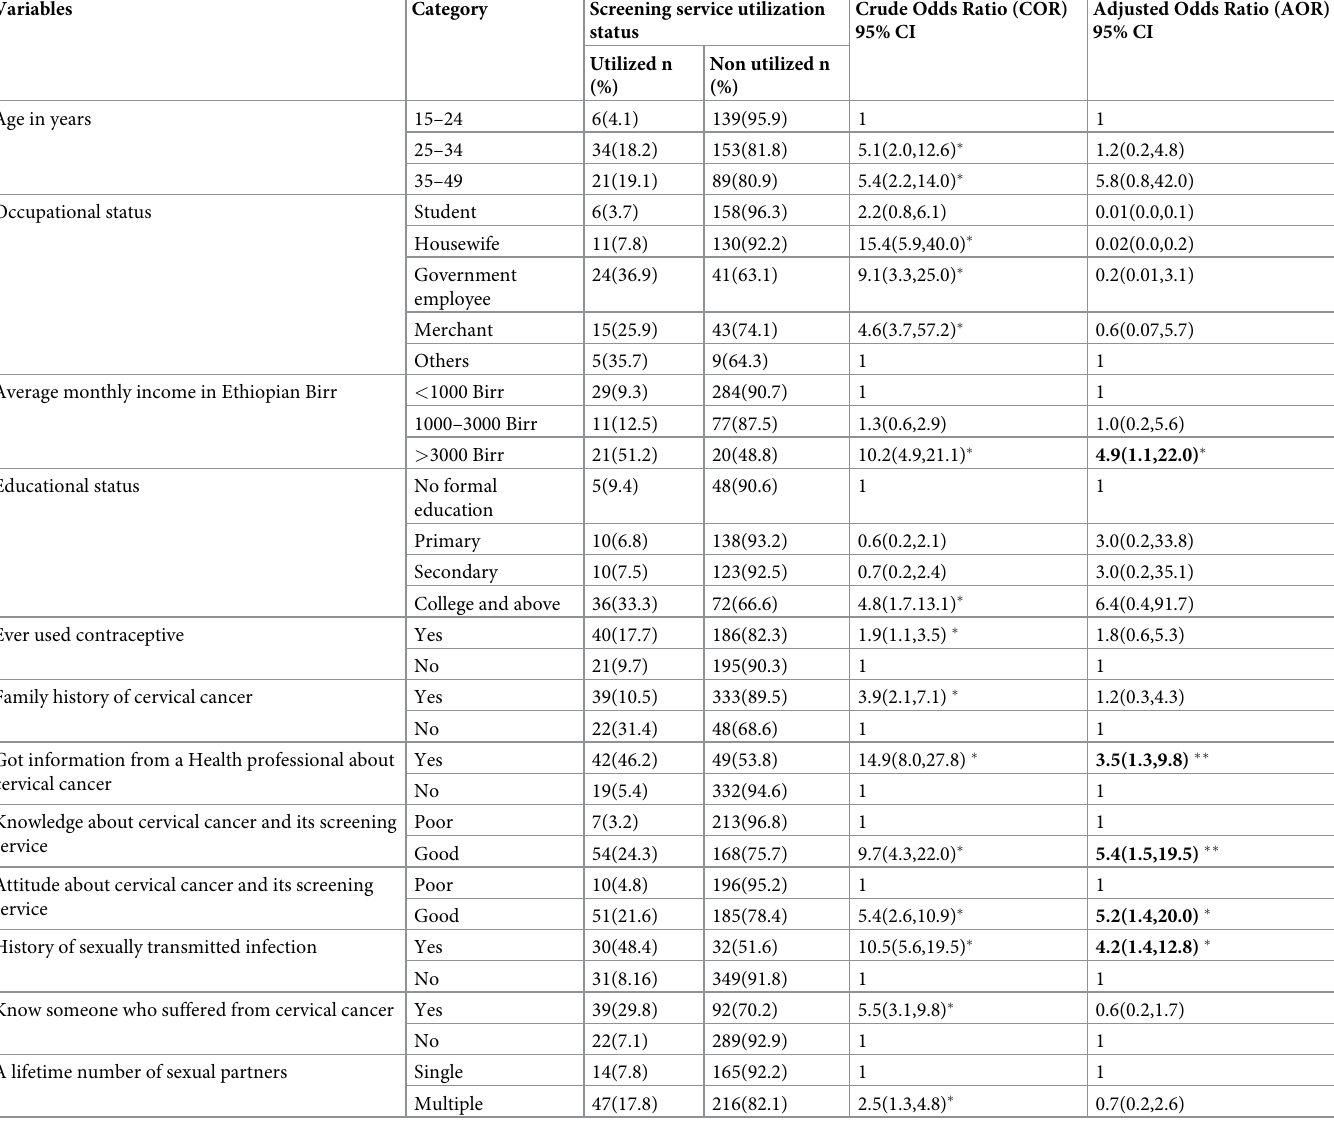
Table 4. Factors associated with cervical cancer screening practice among females of the reproductive age in Durame town, Kembata Tembaro zone, SNNPR, Ethio- pia,